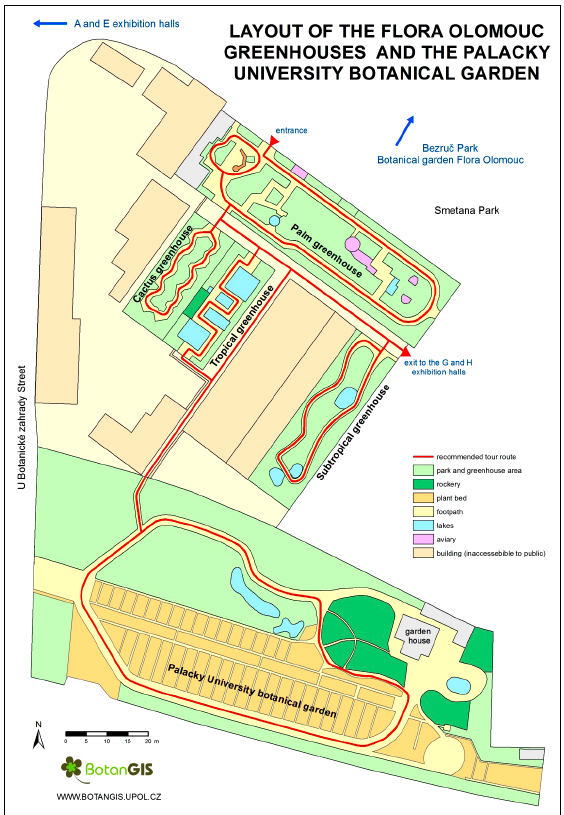
Fig. 11. The plan of the Flora Olomouc greenhouses and the Palacky University botanical garden